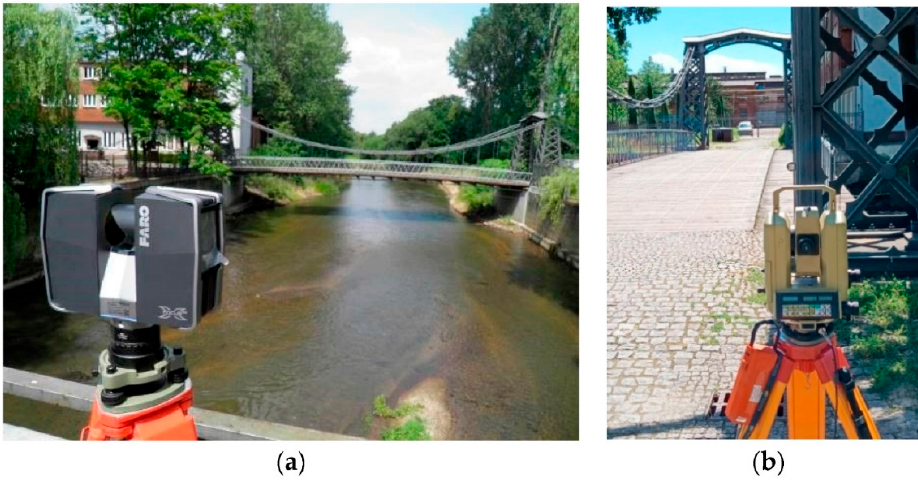
Figure 1. A typical TLS: ( a ) FARO Focus 130 3D laser scanner; ( b ) Leica TC2002 total station [20].